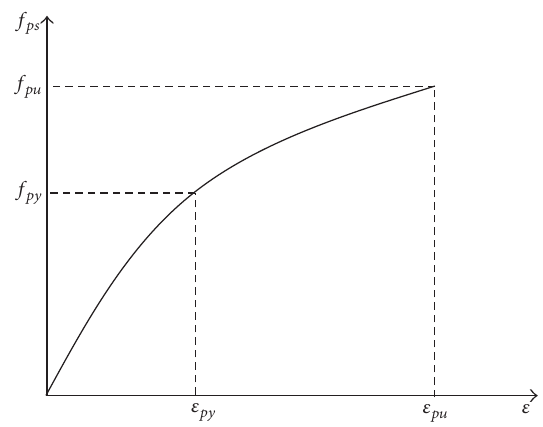
Figure 2: Average stress-strain relationship proposed by Lin and Scordelis (1975).